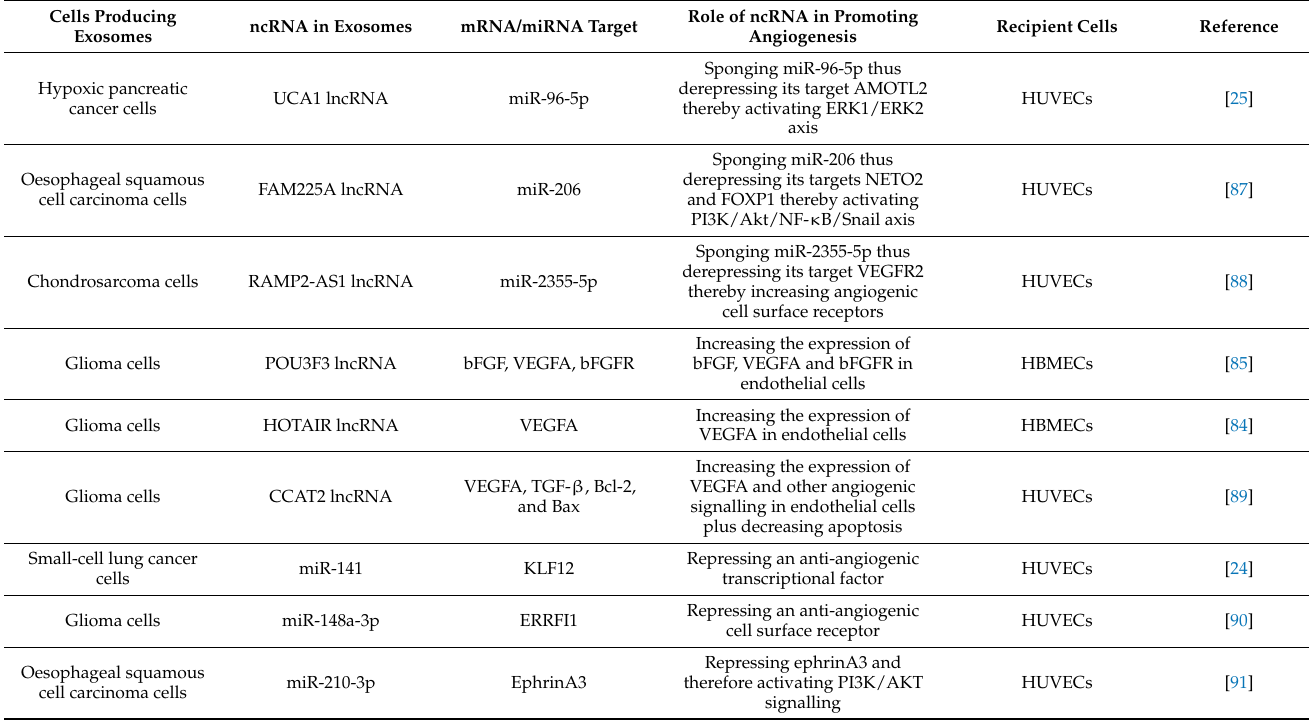
Table 2. Regulation of angiogenic remodelling by exosome-derived non-coding